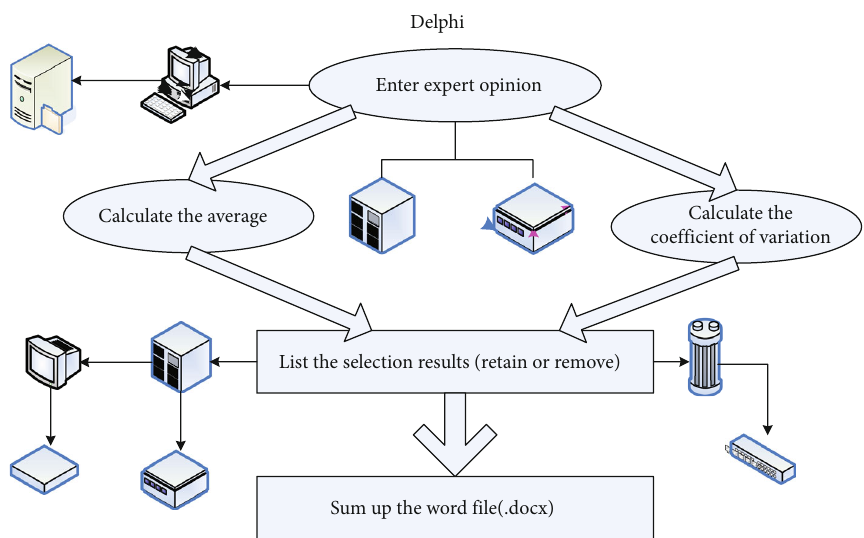
Figure 3: Schematic diagram of the speci fi c process of the Delphi